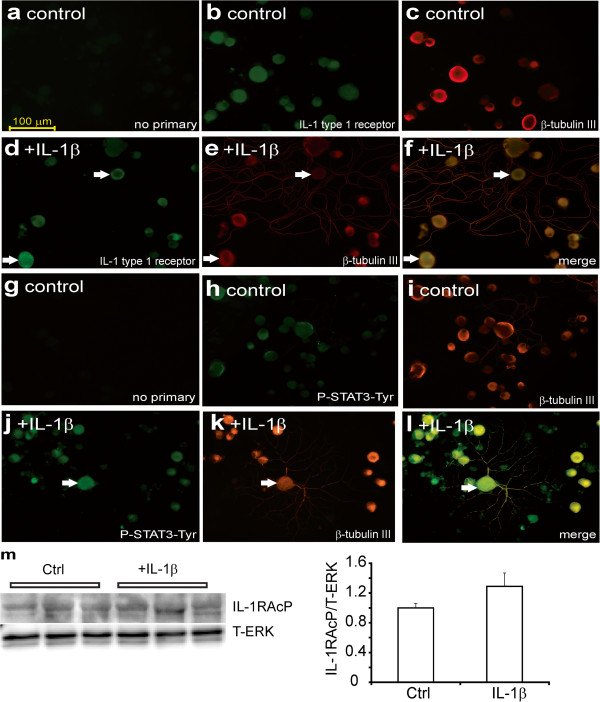
Immunocytochemical staining for the IL-1 type 1 receptor and P-STAT3-Tyr705 in control neurons. DRG sensory neurons from normal rats were cultured for 1 day in the presence of low dose of neurotrophic growth factors and were fixed and immunostained with (a, g) no primary antibody, or stained for (b) IL-1 type 1 receptor antibody or (c) β-tubulin III or (h) P-STAT3-Tyr705 or (i) β-tubulin III. Cultures were also treated for 24 h with IL-1β (10 ng/ml) and stained for (d) IL-1 type 1 receptor or (e) β-tubulin III or (j) P-STAT3-Tyr705 or (k) β-tubulin III. (f) and (l) are merge of (d+e) and (j+k) with secondary staining for neuron-specific β-tubulin III. The white arrows indicate co-localization of IL-1 type 1 receptor or P-STAT3-Tyr705 with neuron-specific staining. The bar = 100 μm. (m) Western blot for IL-1 type 1 receptor comparing control and treated with IL-1β cultures for 30 minutes in vitro with quantification. Expression levels are expressed relative to T-ERK and are means ± SEM (n = 3 replicates); no significant difference between Ctrl and +IL-1β.